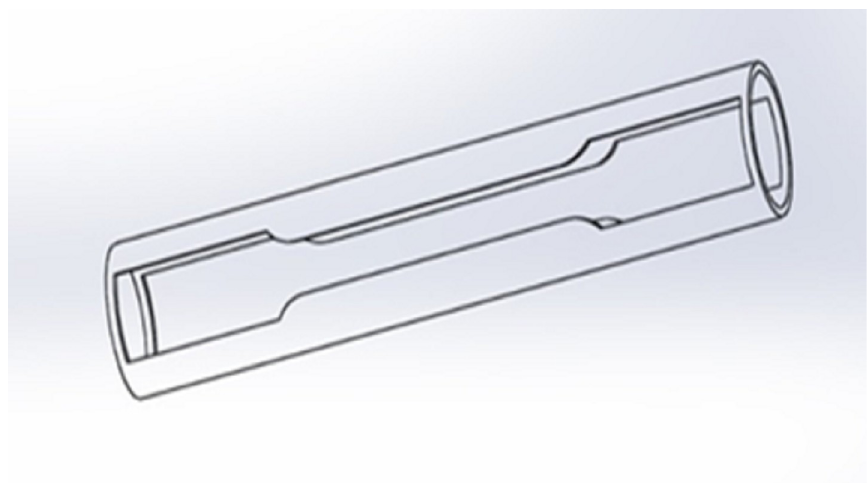
Fig 5. Tube after cutting the longitudinal tensile test specimens.